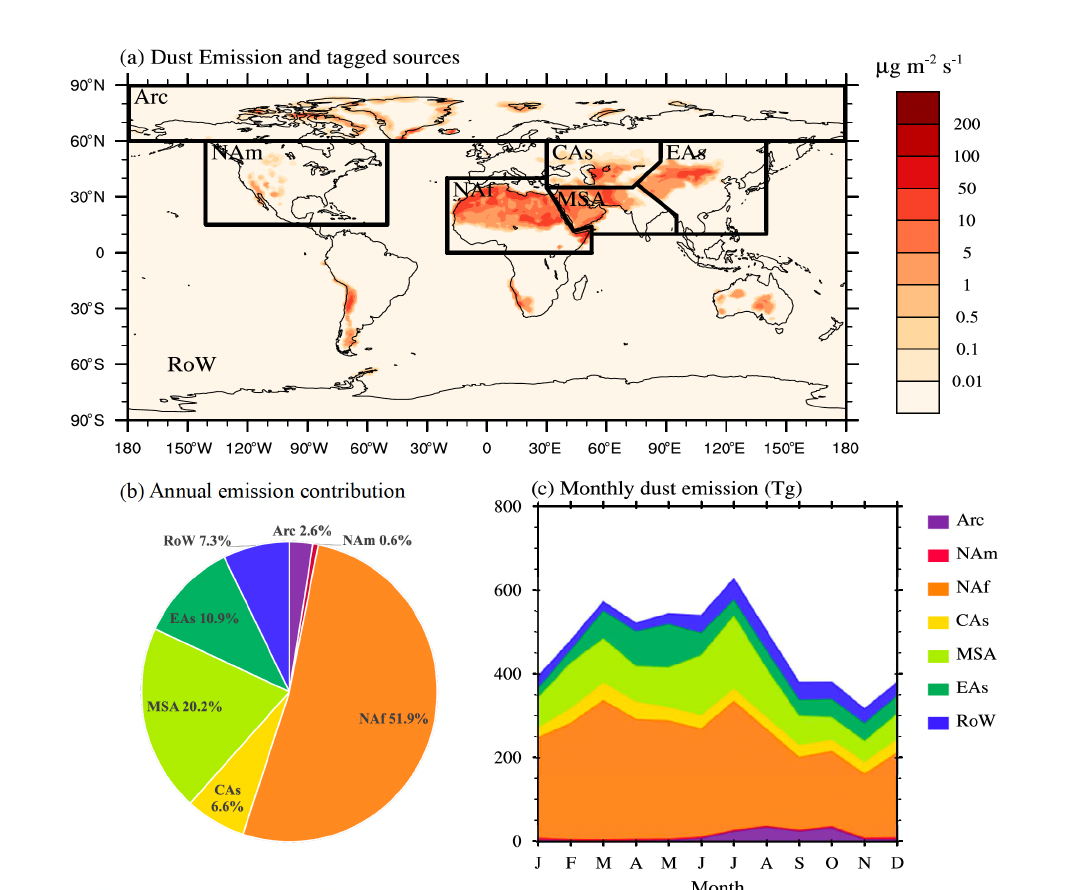
Figure 1. (a) Simulated global annual mean dust emission with seven tagged source regions (Arc: Arctic; NAm: North America; NAf: North Africa; CAs: Central Asia; MSA: the Middle East and South Asia; EAs: East Asia; RoW: rest of the world). (b) The respective percentage contributions to the global annual mean dust emission from the individual source regions. (c) Seasonal cycle of global dust